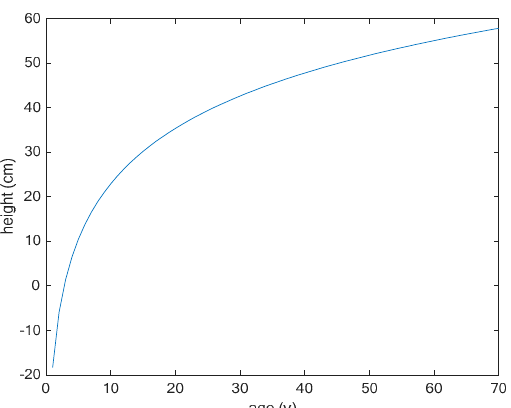
Figure 3. Height estimation of the colonies as a function of age in Eunicella verrucosa according to model B [6].